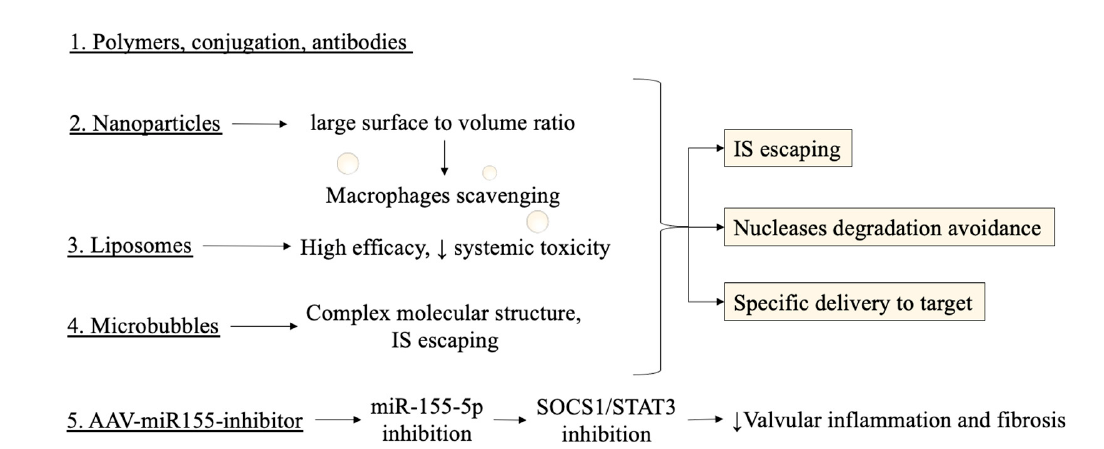
Figure 3. Novel methods and delivery systems for targeting miRNAs are depicted with their respective advantages. IS escaping, nucleases degradation, and specific delivery are features to be achieved by an optimal delivery system. The pathophysiological conclusion from a study regarding AAV-miR155-inhibitor, an adenoviral-based miRNA inhibitor, discussed below in the text, is also reported. IS: immune system, AAV: adeno-associated virus, SOCS1: suppressor of cytokine signaling 1, STAT3: signal transducer and activator of transcription 3.